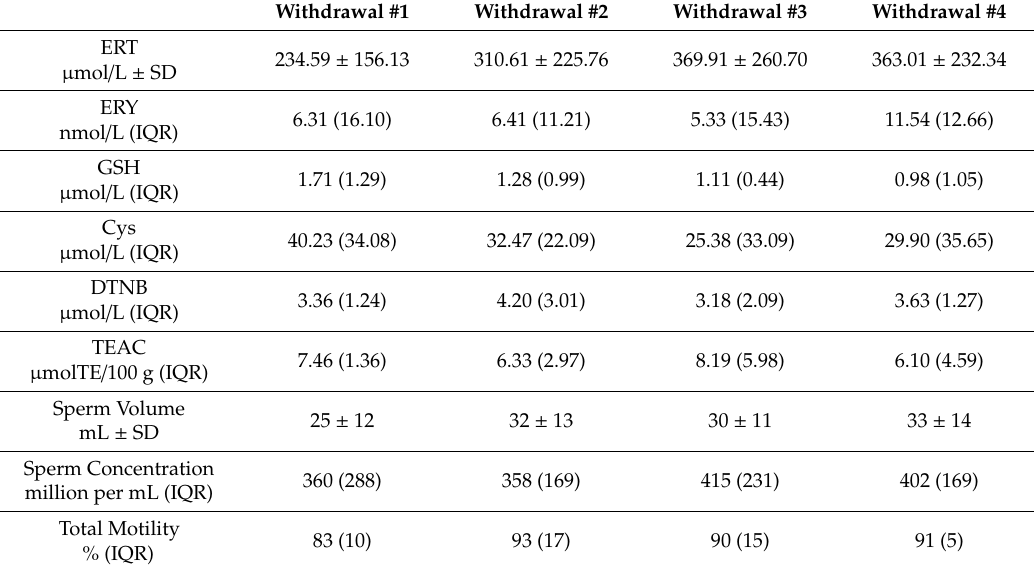
Table 1. Parameters measured in the study. Values are the mean ± SD or median (interquartile range (IQR)) of the levels reached during the four